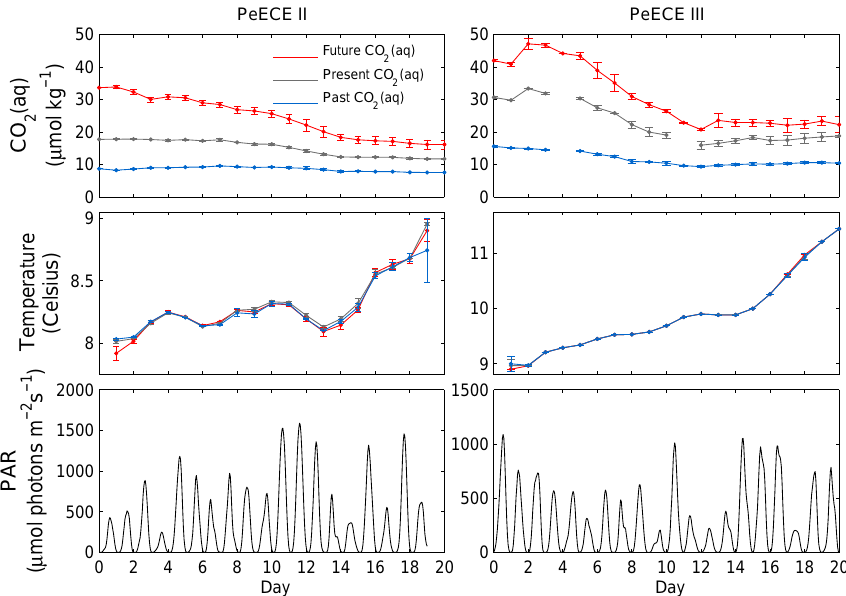
Figure 9. Environmental data from PeECE II and III are taken as model inputs. Error bars denote the standard deviation of the same treatment